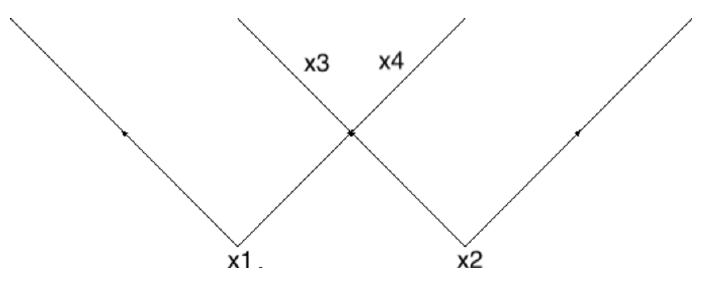
Figure 1 . Lorentzian con(cid:12)guration for the bulk point